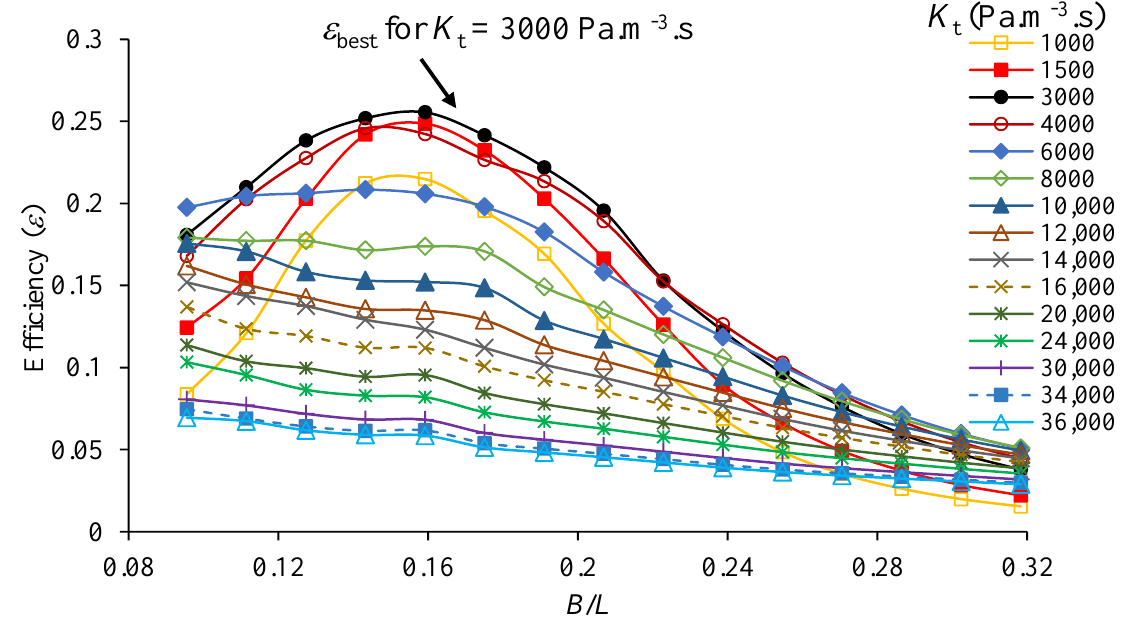
Figure 2. Effects of the turbine coefficient for fixed OWC device at ( d / h = 0.25) on efficiency with B / L for different turbine coefficient.